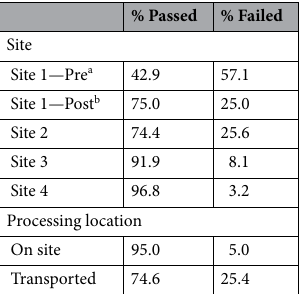
Table 3. Quality control pass/fail rate by site. a Samples transported on ice prior to protocol change. b Samples transported at room temperature post protocol